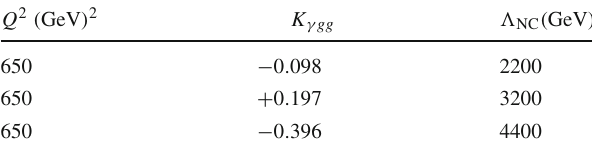
− 0 . 098 2200 Table 2 (cid:4) NC variations with parameter K γ gg for a fixed Q 2 = 650 ( GeV ) 2 Q 2 ( GeV ) 2 K γ gg (cid:4) NC ( GeV )